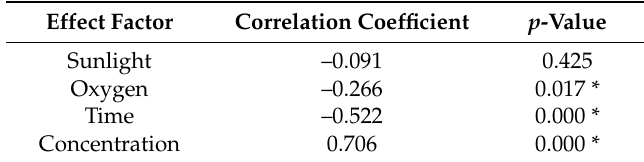
Table 4. Pearson correlation coefficient between the percentage of the residual concentration of EGCG and effect factors.